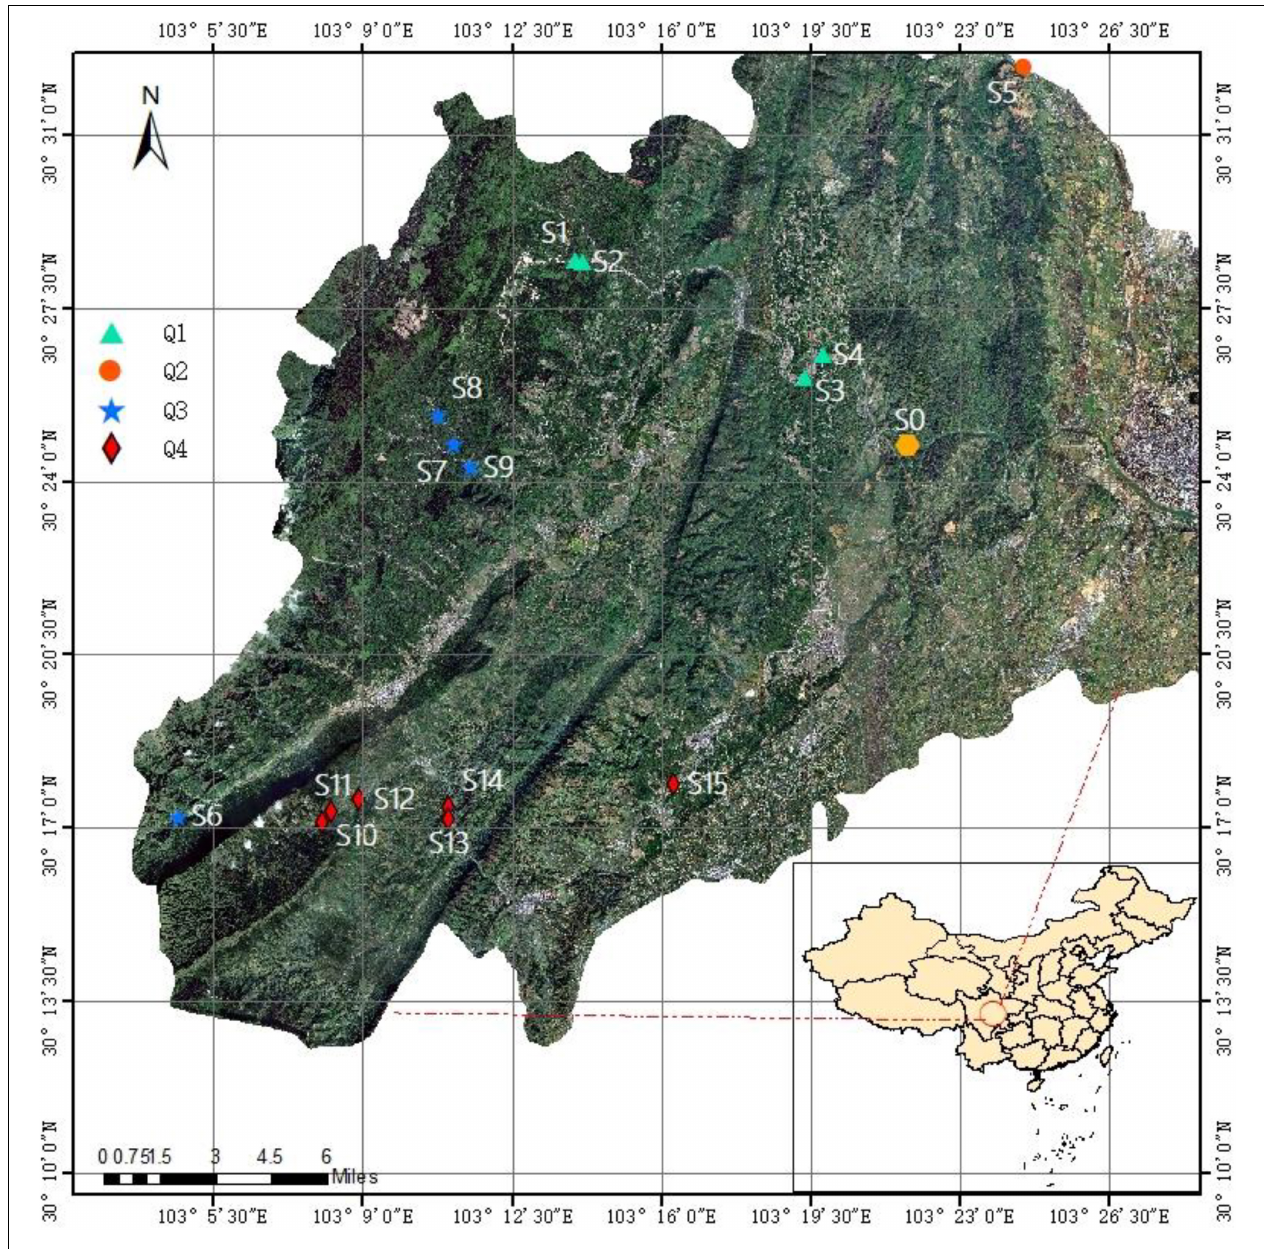
FIGURE 1 | Distribution of sampling points in Qionglai